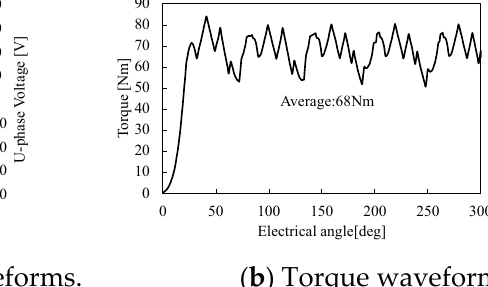
Figure 14. Rotation speed of 52,000 min -1 , turn-on angle of − 40 degrees, and turn-off angle of 51 degrees.